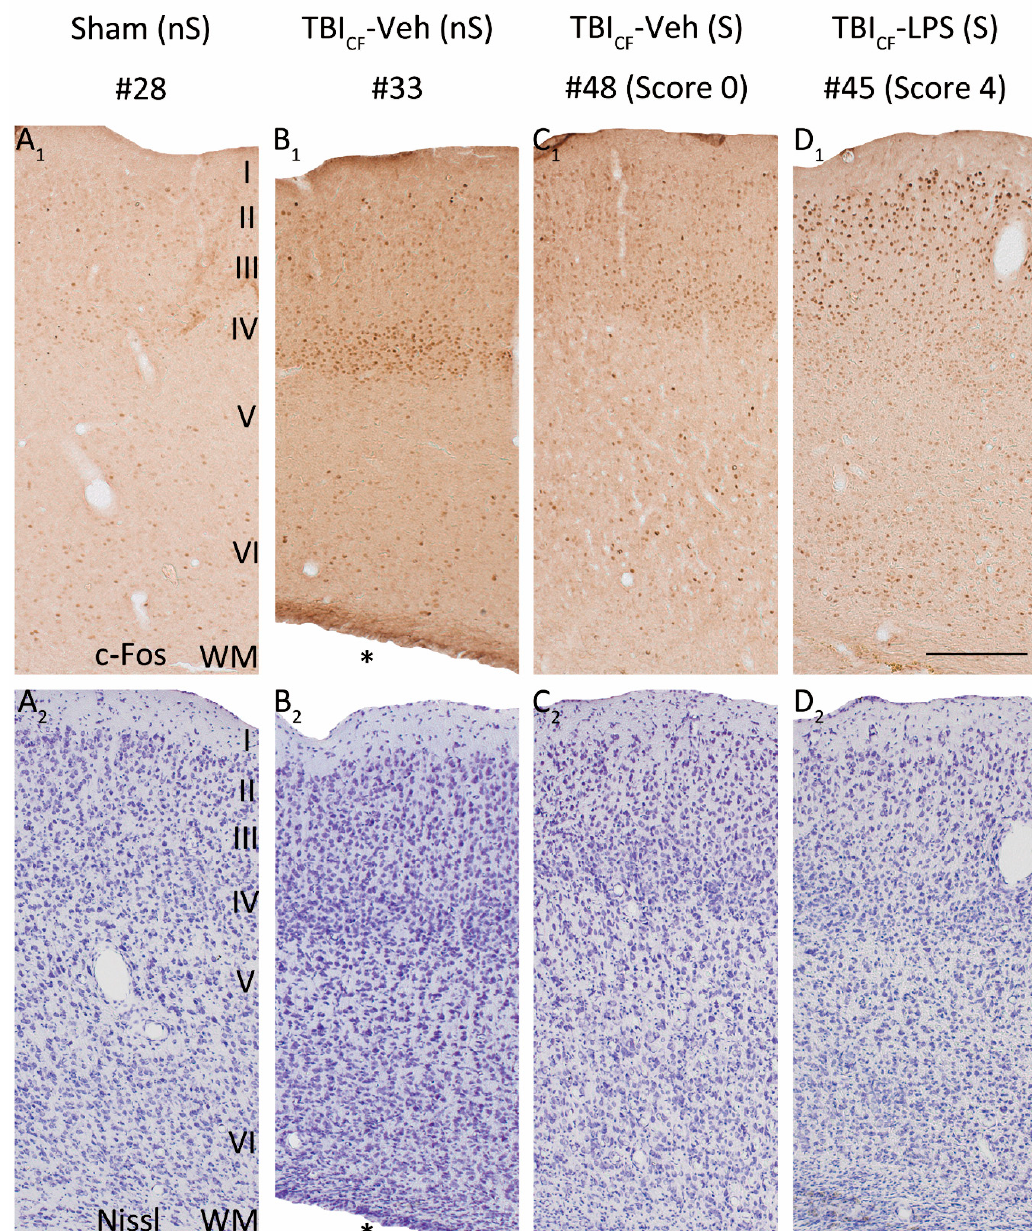
Figure 8. Pattern of c-Fos expression in the rostromedial perilesional cortex. Representative high magnification photomicro- graphs showing c-Fos immunochemistry ( A 1 – D 1 ) and Nissl staining ( A 2 – D 2 ) in the rostromedial perilesional cortex in rats from the Sham-Veh group and TBI CF endophenotype at 2 h after PTZ injection (23 weeks post-FPI and 15 weeks after LPS injection). ( A 1 , A 2 ) Example of a rat from the Sham-Veh group without a PTZ-induced seizure (#28). ( B 1 , B 2 ) Example of a rat from the TBI CF -Veh group without a PTZ-induced seizure (#33). ( C 1 , C 2 ) Example of a rat from the TBI CF -Veh group with a PTZ-induced seizure (#48, seizure Racine score 0, only electroencephalographic seizure). ( D 1 , D 2 ) Example of a rat from the TBI CF -LPS group with a PTZ-induced seizure (#45, seizure Racine score 4). Note that in rats without a PTZ-induced seizure, TBI increased PTZ-induced c-Fos expression, particularly in layer IV (( B 1 ) vs. ( A 1 )). In the TBI CF -Veh group, a rat with a PTZ-induced seizure ( C 1 ) revealed higher c-Fos activation compared to a rat without a seizure ( B 1 ), particularly in the supragranular layers. In the TBI CF endophenotype with a PTZ-induced seizure, LPS treatment at a chronic time-point after TBI further enhanced c-Fos expression ( D 1 ) compared with vehicle treatment ( C 1 ) in all layers. Abbreviations: CF, cavity-forming; FPI, fluid-percussion injury; LPS, lipopolysaccharide; nS, no seizure; PTZ, pentylenetetrazole; S, seizure; TBI, traumatic brain injury; Veh, vehicle; WM, white matter. Scale bars = 200 µ m. * Enlarged ipsilateral lateral